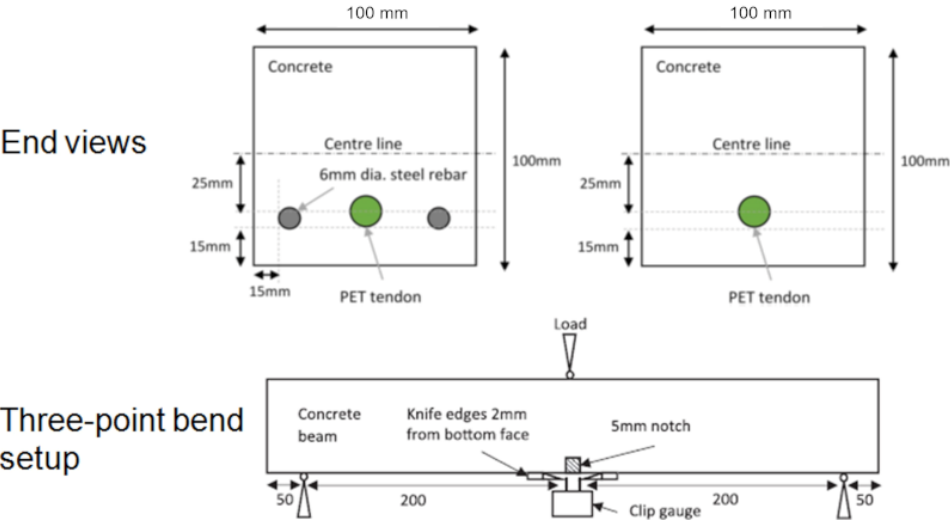
Figure 5. Three-point bend setup and location of tendons, all dimensions in mm, adapted from [42].